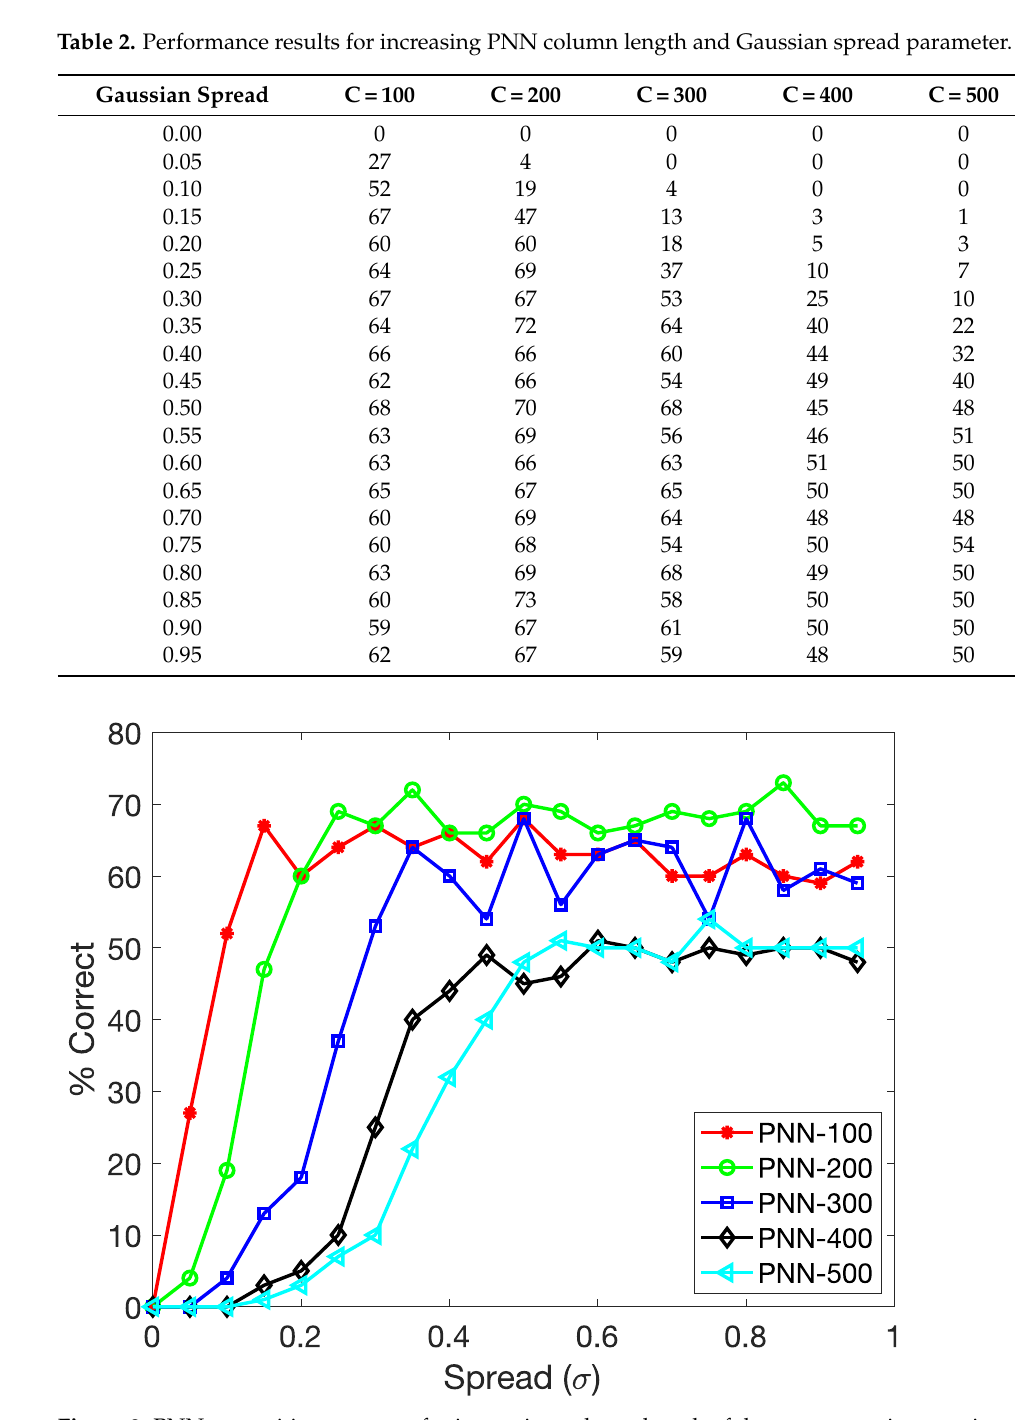
Figure 9. PNN recognition accuracy for increasing column length of the pre-processing